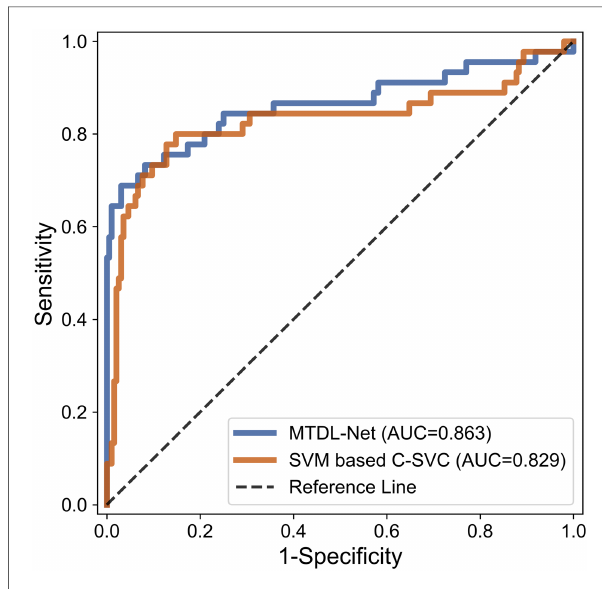
FIGURE 10 ROC curves for WMI status prediction based on different classi fi er in the testing cohort.